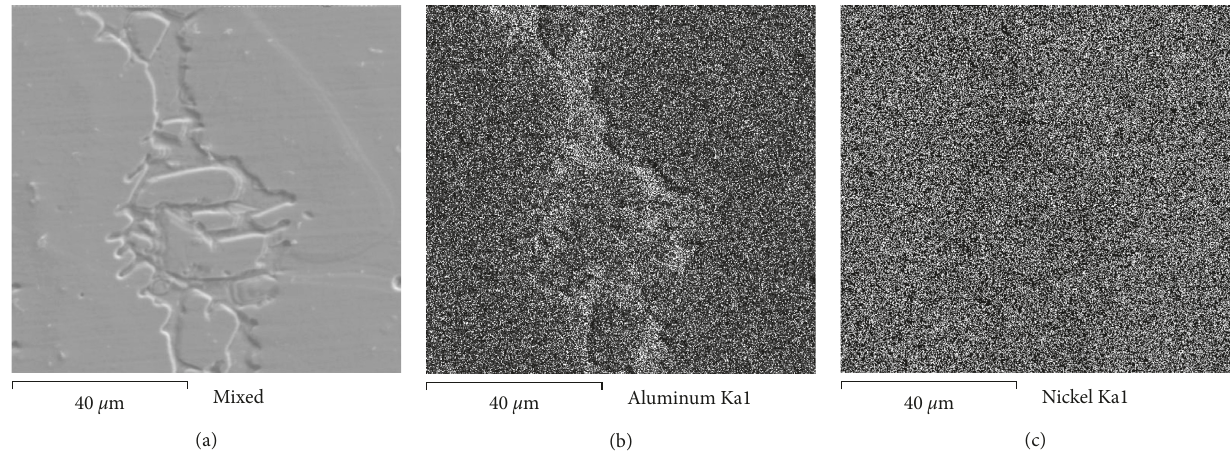
Figure 2: Microstructure of the Ni 75 Al 25 intermetallic alloy (a) and EDXA mapping for Al (b) and Ni (c) of the dendrite